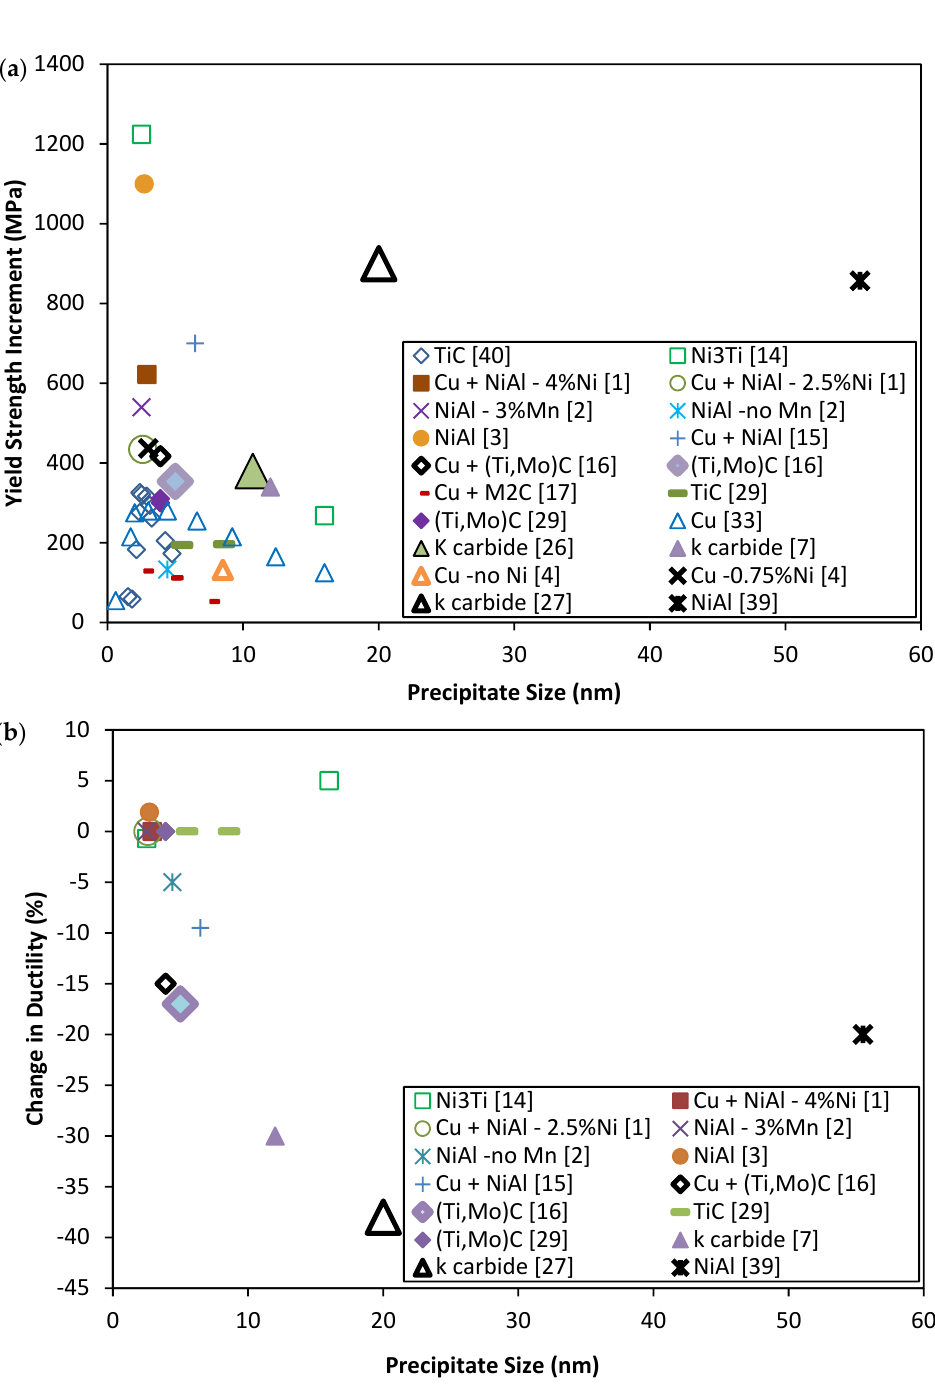
Figure 2. A compilation of ( a ) yield strength increment and ( b ) ductility change against precipitate number density of various precipitate strengthened steels.